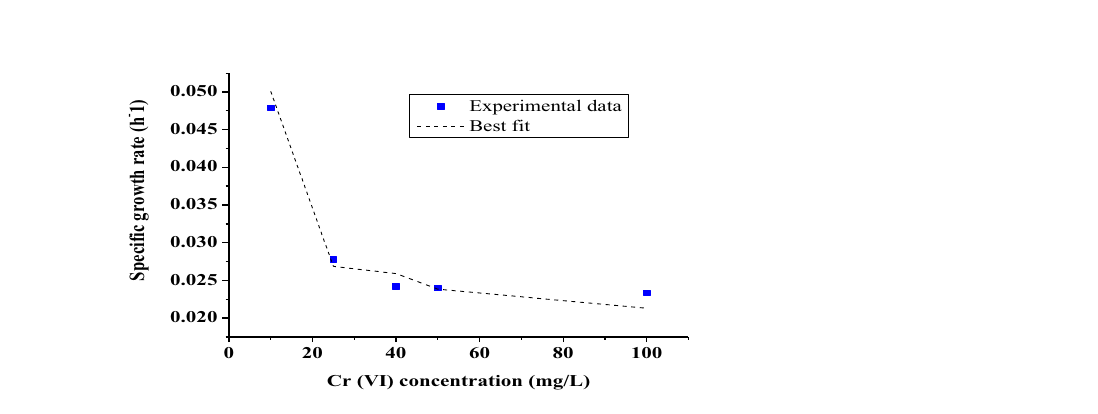
Table 3. Growth kinetic parameters of Serrtia sp. for tertiary substrate system.